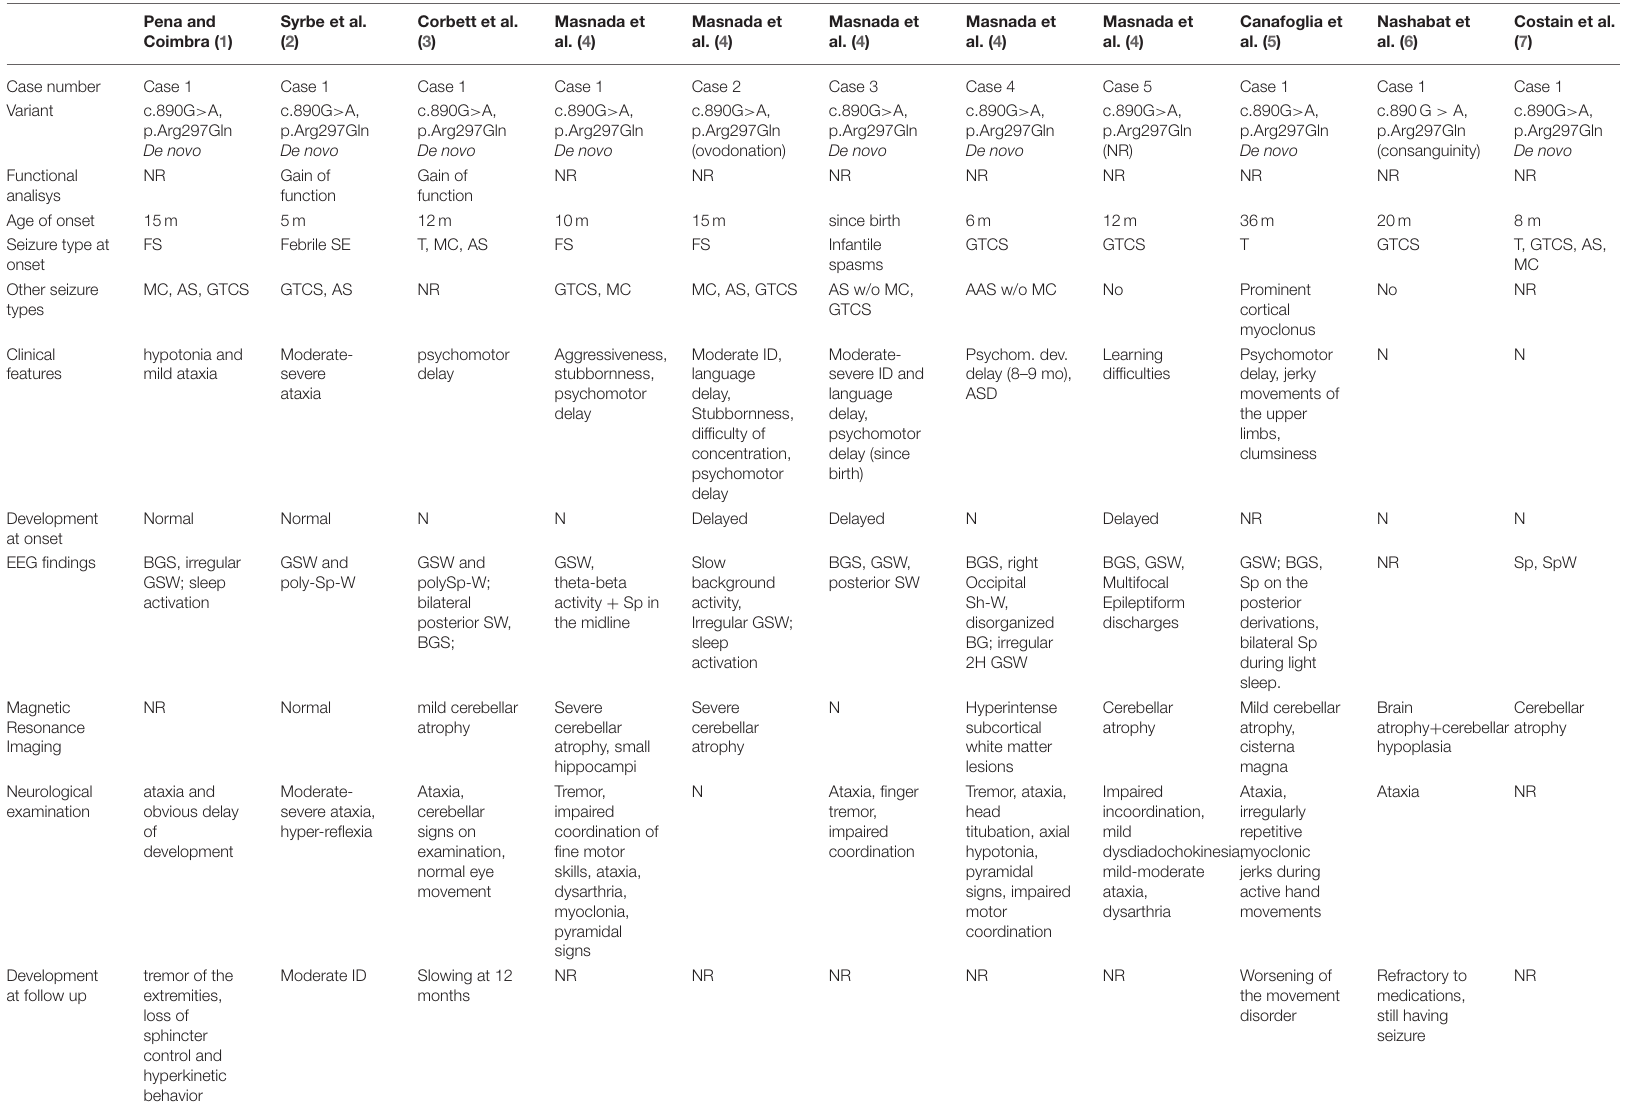
TABLE 1 | Comparison between the characteristics of patients reported in the literature with mutation in the same triplet encoding an amino acid as the patient analyzed in this